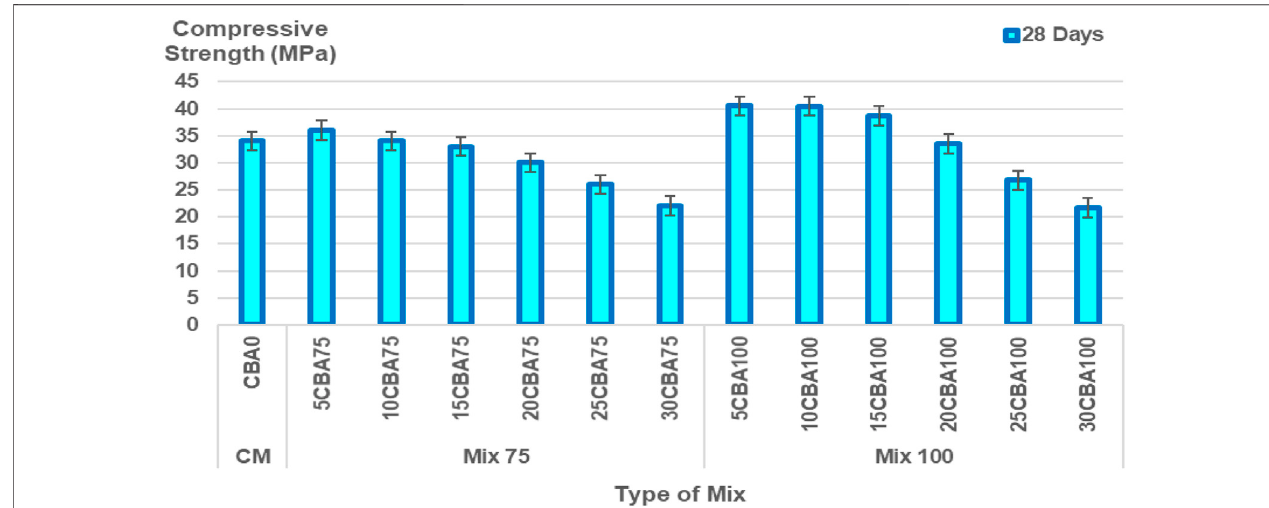
FIGURE 6 | Compressive strength (MPa) of Mix 75 and Mix 100 at 28